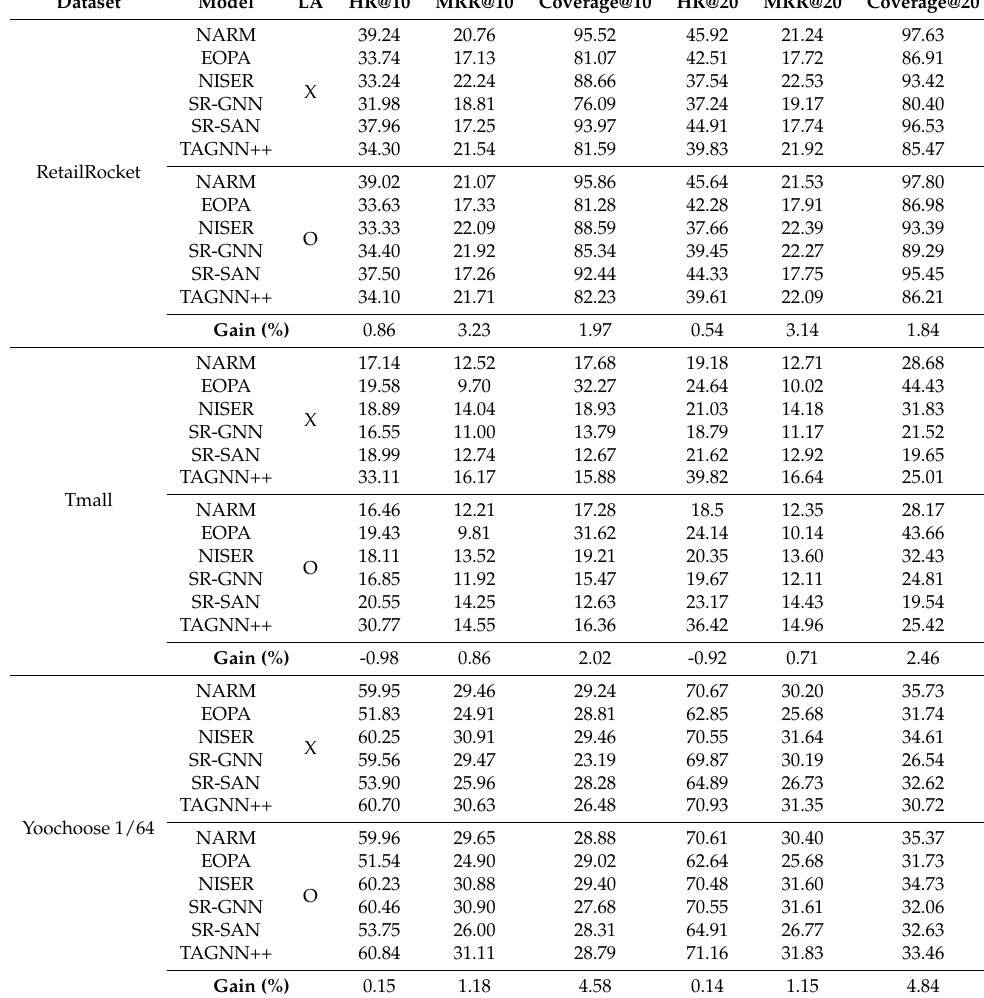
Table 2. The performance result with and without LA (Logit Averaging) method. In column LA, we mark ’X’ to indicate the baseline without using LA and mark ’O’ to indicate the baseline with using LA. Gain (%) is the average gain of the baselines with LA on the original